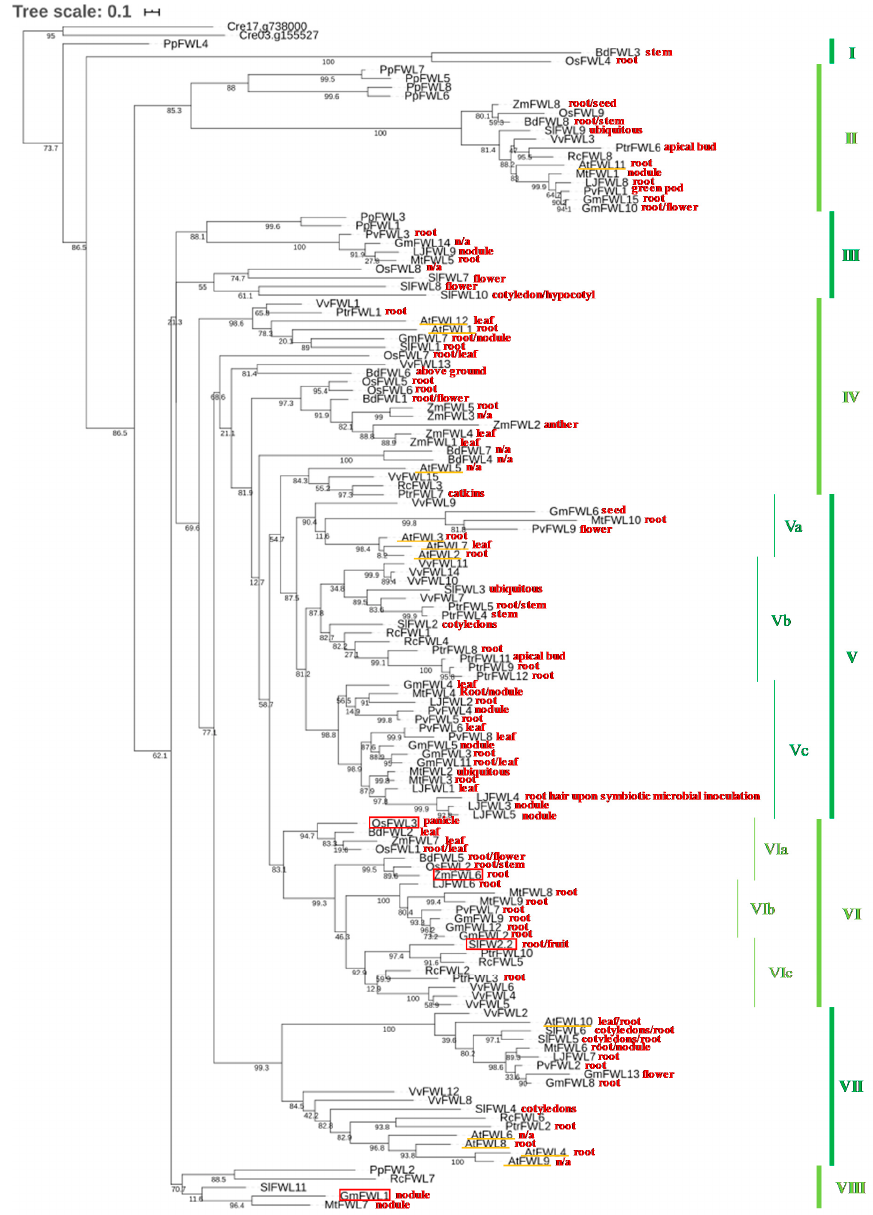
Figure 1. Phylogenetic tree of the FWL / CNR family. Members of the FWL / CNR family were identified with BlastP analysis against the genomic sequence of 13 di ff erent plant species. The 103 FWL / CNR protein sequences reported in Libault et al. (2010) [36] were used as queries in the Phytozome database (https: // phytozome.jgi.doe.gov / ; e-value ≤ 10e − 20 and score ≥ 100). Alignment and phylogenetic reconstructions were performed using the function “build” of ETE3 v3.1.1 [61] as implemented on GenomeNet (https: // www.genome.jp / tools / ete / ). The multiple sequence alignment was performed using the CLUSTAL W Multiple Sequence Alignments Program with default parameters [62]. The tree was constructed using fasttree with slow NNI (Nearest Neighbor Interchange) and MLACC (maximum likelihood accuracy) = 3 (to make the maximum-likelihood NNIs more at nodes exhaustive) [63]. Values are SH-like local support. Two Chlamydomonas reinhardtii proteins (Cre17.g738000 and Cre03.g155527) were used to root the tree. The tree representation was generated using https: // itol.embl.de / tree / . This tree was divided into eight major clades (I to VIII). Among them, Clades V and VI were divided into three distinctive subclades. Upon mining transcriptome atlases, we highlighted in red characters the tissue / organ where each FWL / CNR gene was the most